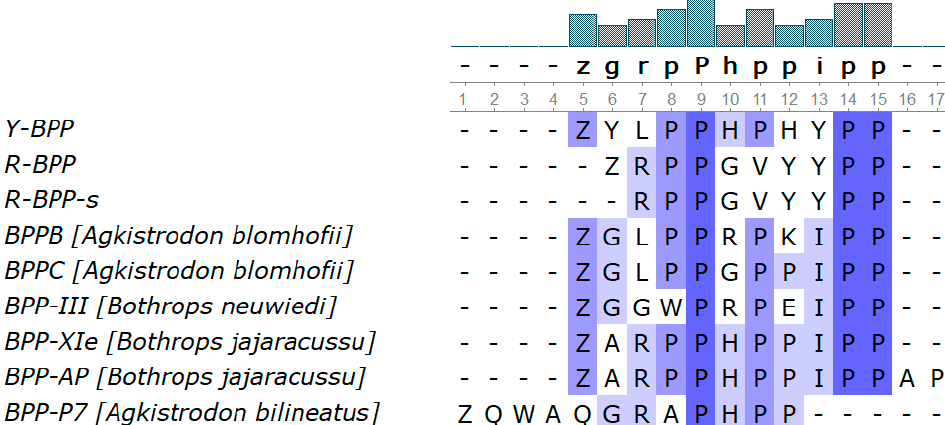
Figure 7. Bradykinin-potentiating peptides (BPP). Comparison of amino acid sequences of A. feae peptides with those of known bradykinin-potentiating peptides (pyroGlu = Z). The number of each consensus letter is represented by a histogram on the top of the figure. Alignment was generated by MUSCLE with percentage identity coloring scheme where the white color is corresponding to 0% identity and the darkest color to 100%.